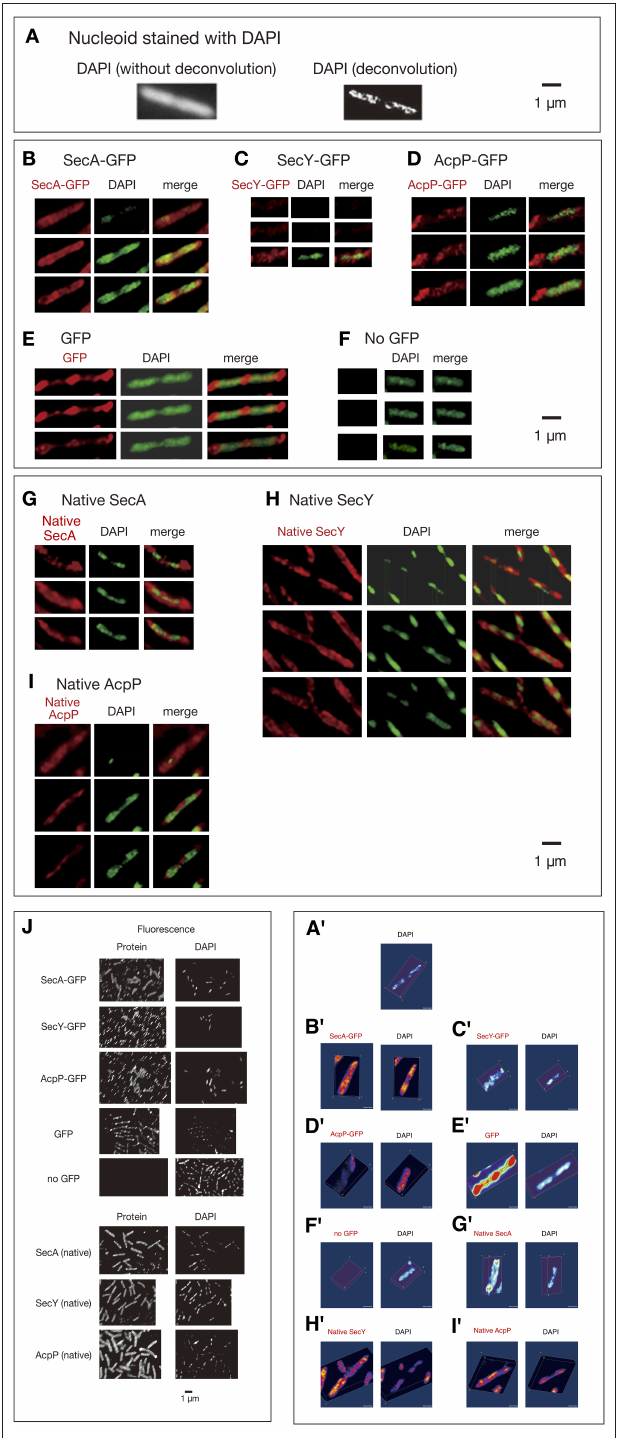
FIGURE 1 | Three-dimensional deconvoluted images of various immunostained proteins. Cells were grown in medium L at 30 ◦ C and fixed with 70% methanol. Red, immunofluorescence of GFP or native proteins. Green, DAPI staining. Merge, merged images of red and green images. Note that synthesized yellow signal is only recognizable with eyes when the ratio of each signal is between ∼ 4:6 and 6:4. More difference is recognizable as mere green